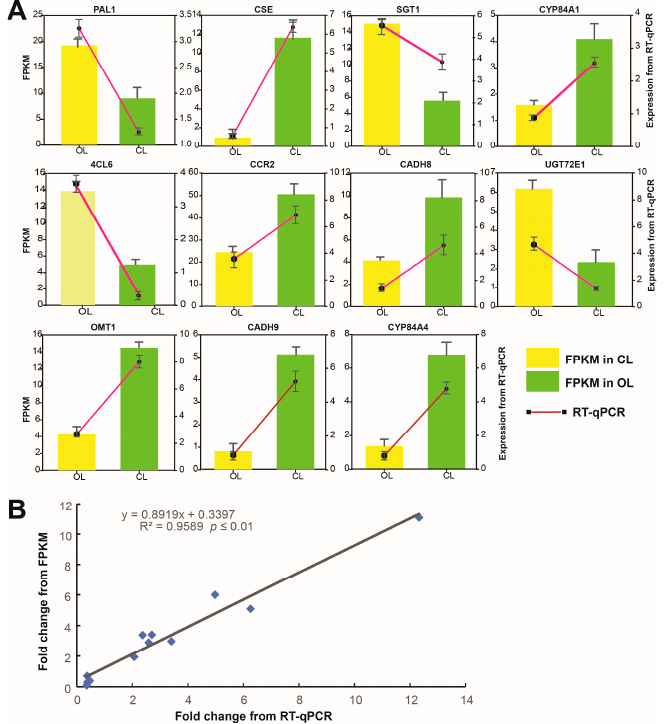
Figure 6. Analysis of the RT-qPCR results: ( A ) expression levels of the selected genes and ( B ) integrative correlation between the RT-qPCR and transcriptome results.